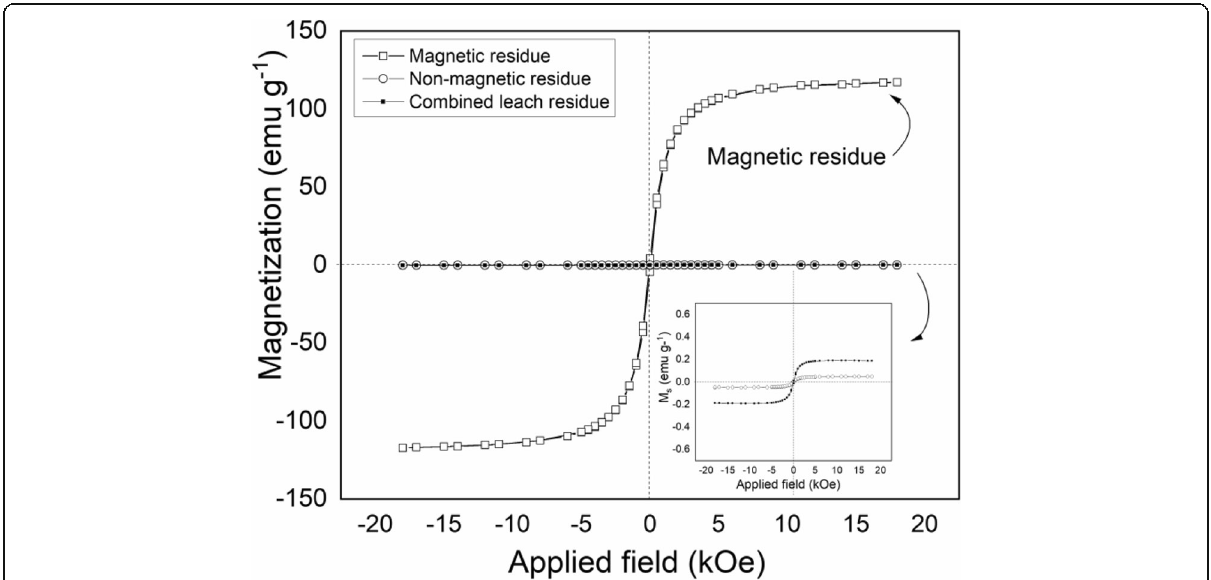
Fig. 6 Magnetic hysteresis loops of the different residues: combined residue of screen wastes leached for 60 min in pyrophosphate solution with ultrasonic energy (US) at pH 6, as well as the non-magnetic and the magnetic residues